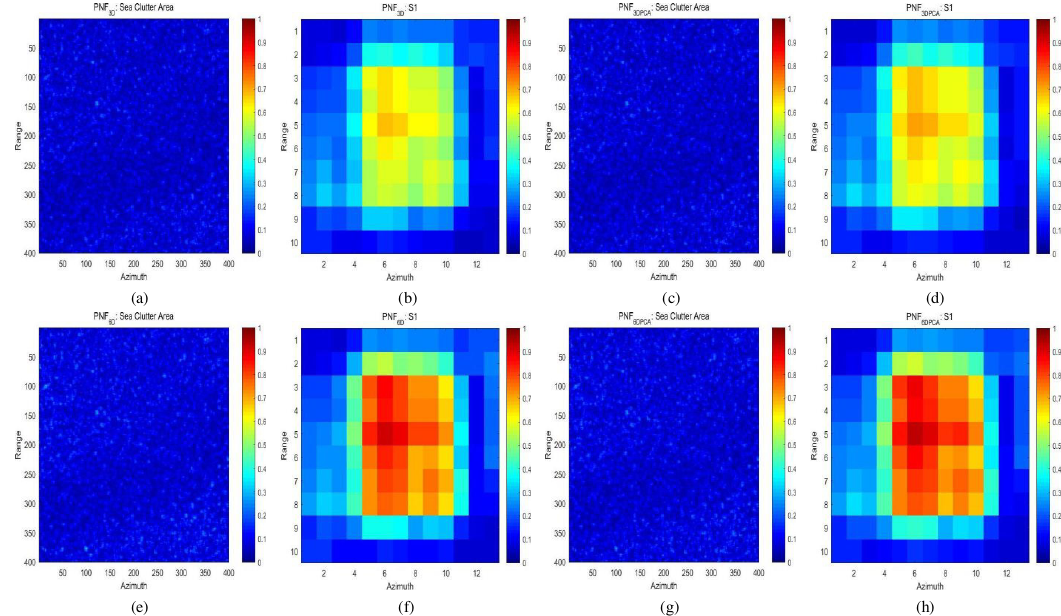
Figure 7. P T values of the sample sea area and S1. ( a ) PNF 3D : The values of sea clutter; ( b ) PNF 3D : the values of S1; ( c ) PNF 3DPCA : the values of sea clutter; ( d ) PNF 3DPCA : the values of S1; ( e ) PNF 6D : the values of sea clutter; ( f ) PNF 6D : the values of S1; ( g ) PNF 6DPCA : the values of sea clutter; ( h ) PNF 6DPCA : the values of S1. Note that the units of the colorbar are normalized.